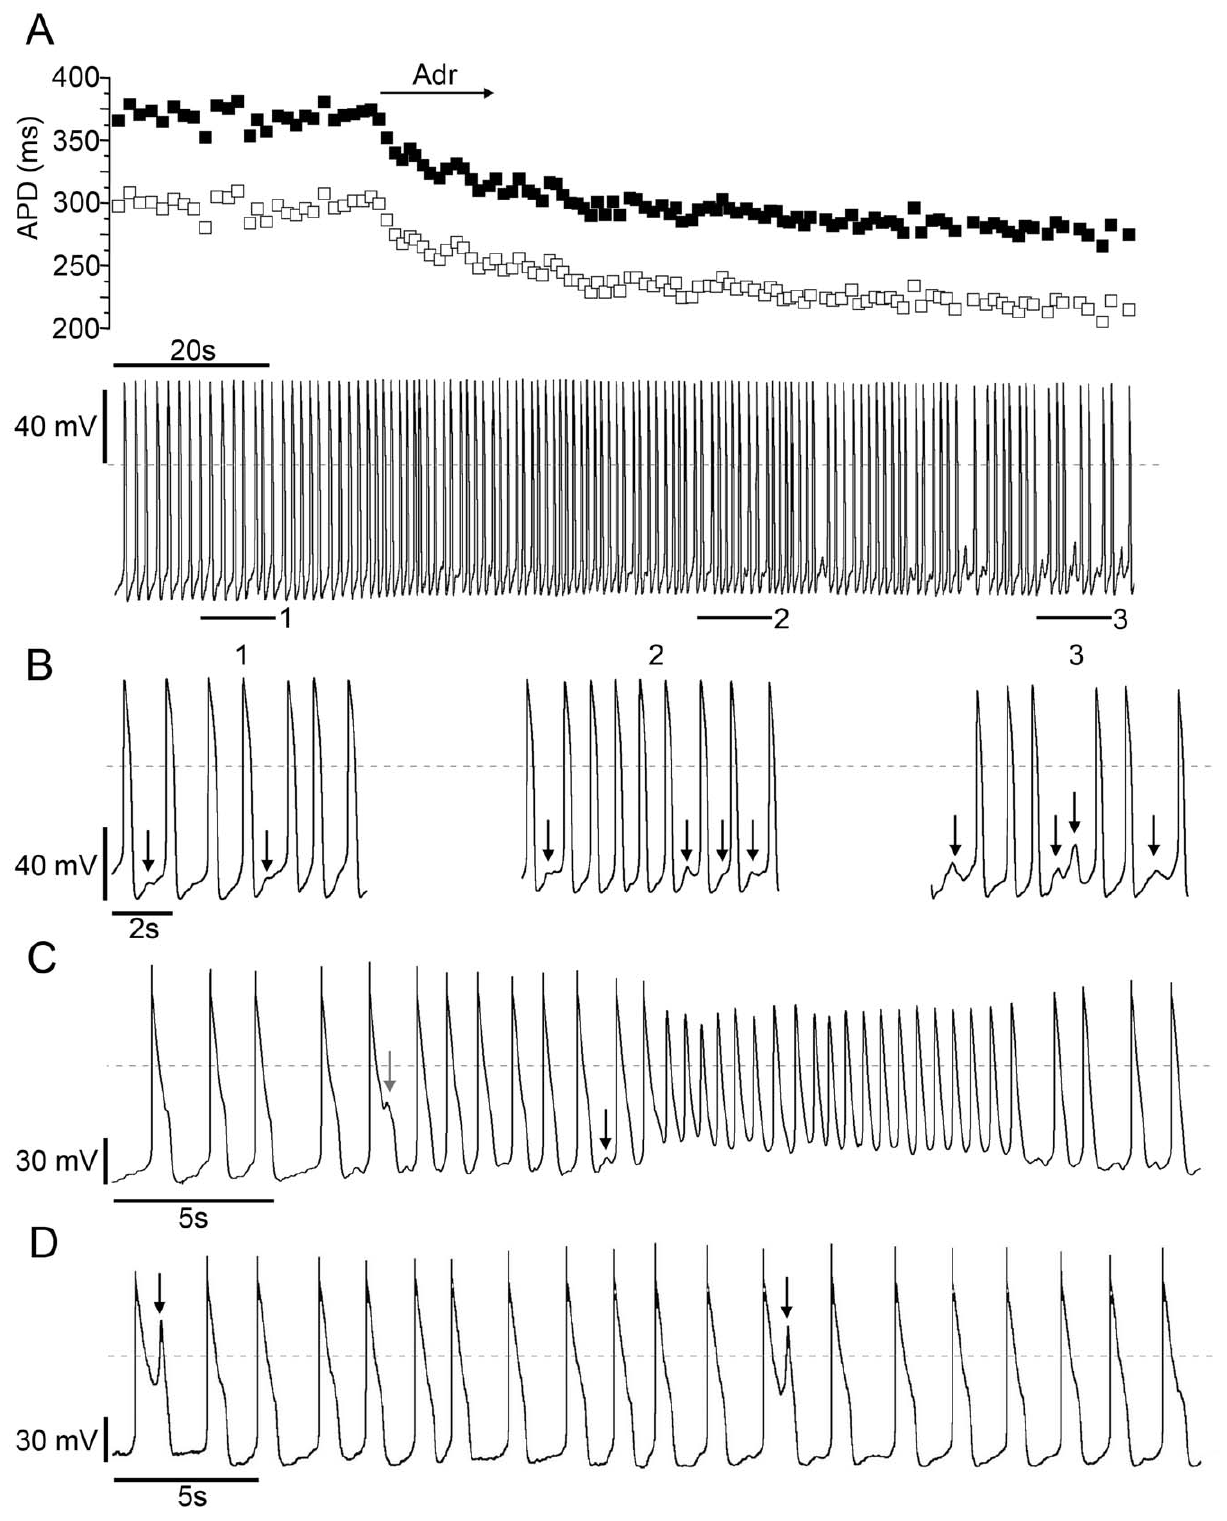
Figure 5. CPVT- P2328S CMs display DADs and EADs. A , Time course of APD 50 (empty squares) and APD 90 (filled squares) Adr indicates perfusion with adrenaline. B , bars 1–3 are 9 sec time courses enlarged from A . (1) baseline with DADs, (2) DADs in the presence of adrenaline, (3) DADs continue after adrenaline perfusion. MDP 2 70 mV. Arrows indicate DADs. C , A CPVT- P2328S CM showing an EAD (grey arrow) and a DAD (black arrow) followed by a spontaneous burst episode (MDP 2 50 mV, maximum upstroke amplitude 45 mV). D , Current clamp recording of a CPVT- P2328S CM showing occasional EADs (arrows). MDP 2 70 mV. Dashed lines indicate the zero reference potential.